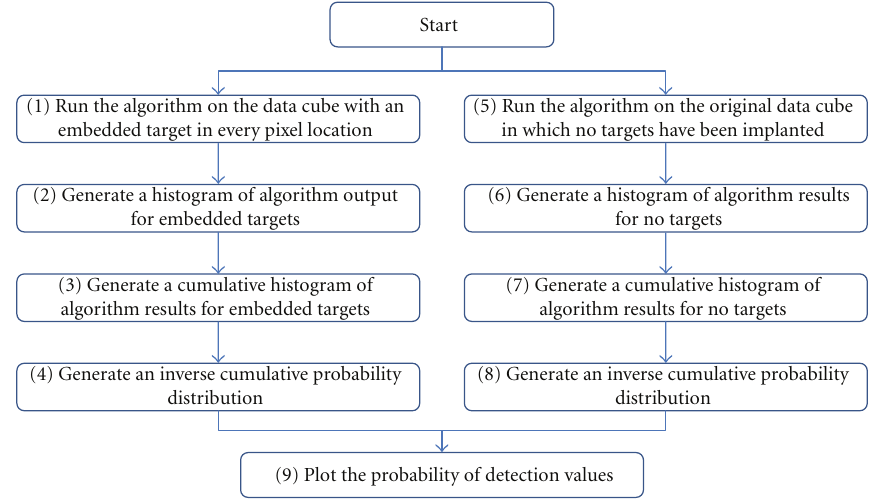
Figure 1: RBTA flow